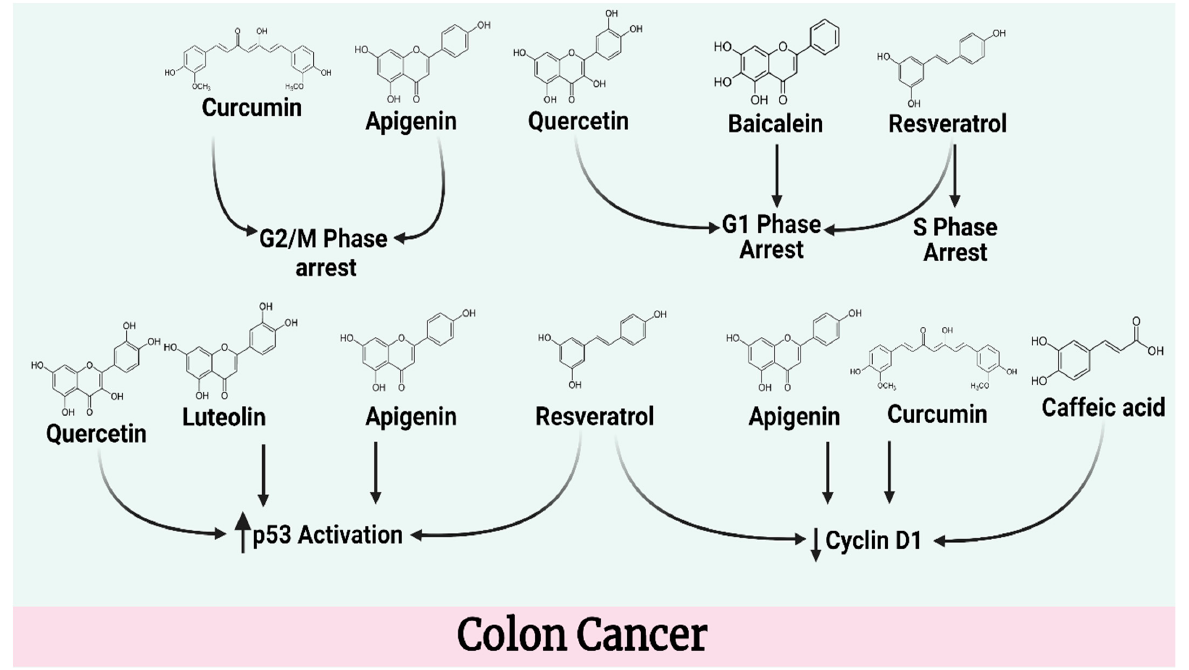
Figure 4. Illustration representing probable sites of blockade by small molecules in colon cancers.